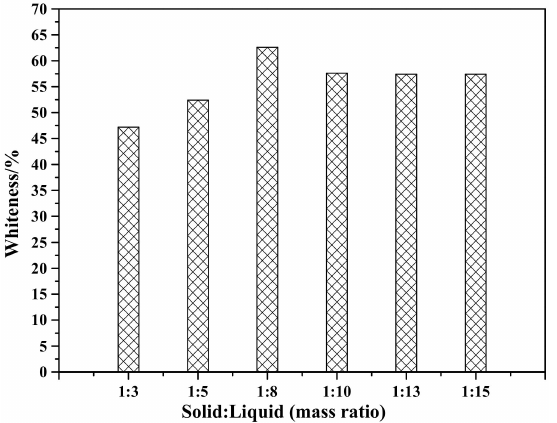
Figure 10. Whiteness of ZCFA powder at di ff erent solid-to-liquid ratios.